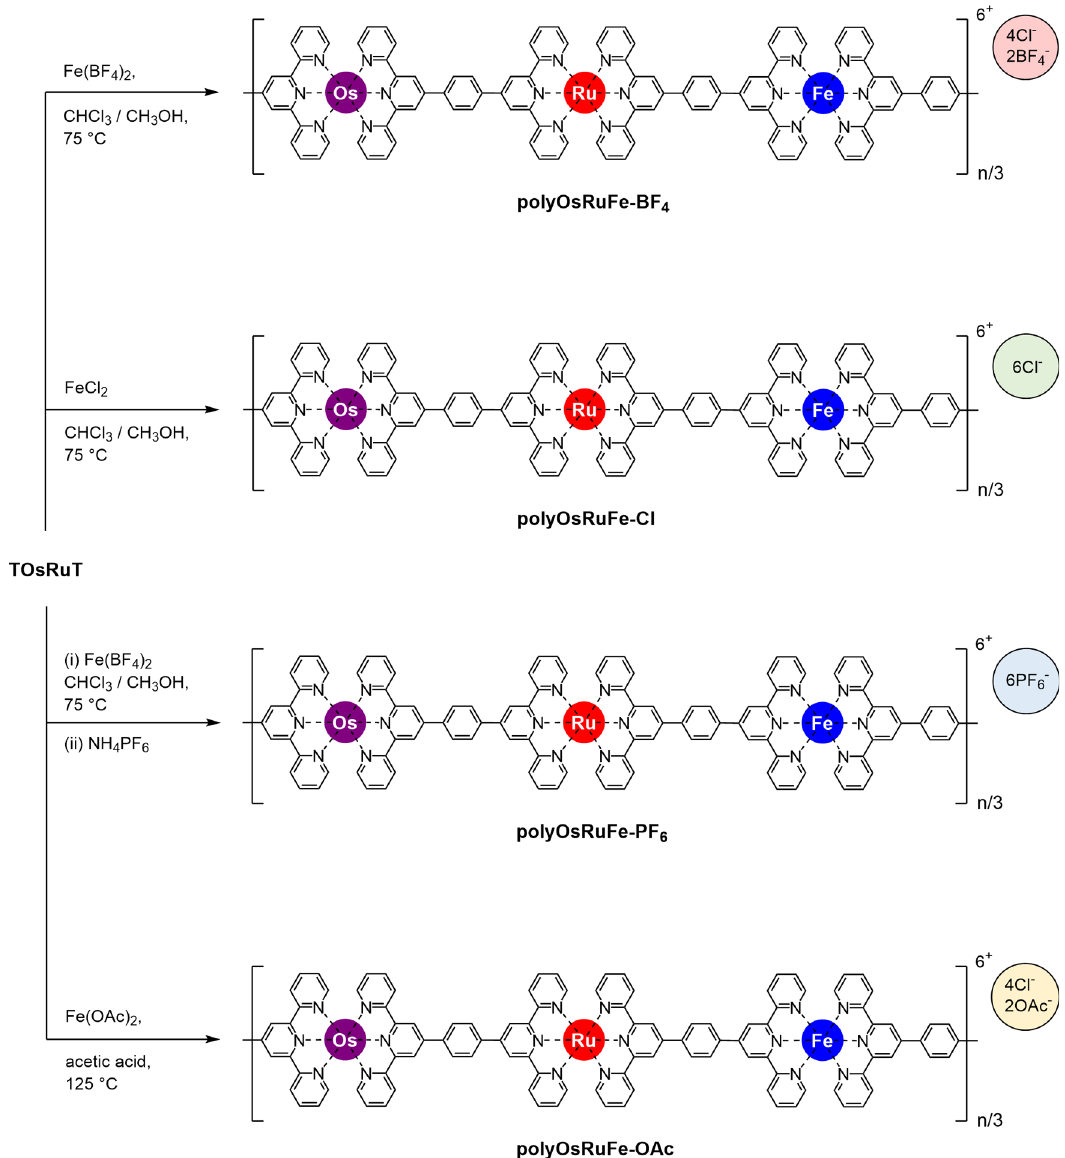
Fig. 6 Synthesis and chemical structure of polyOsRuFe-A (A = BF 4 , Cl, PF 6 , and OAc). Synthetic route to polyOsRuFe with various counteranions, called polyOsRuFe-A (A = BF 4 , Cl, PF 6 , and